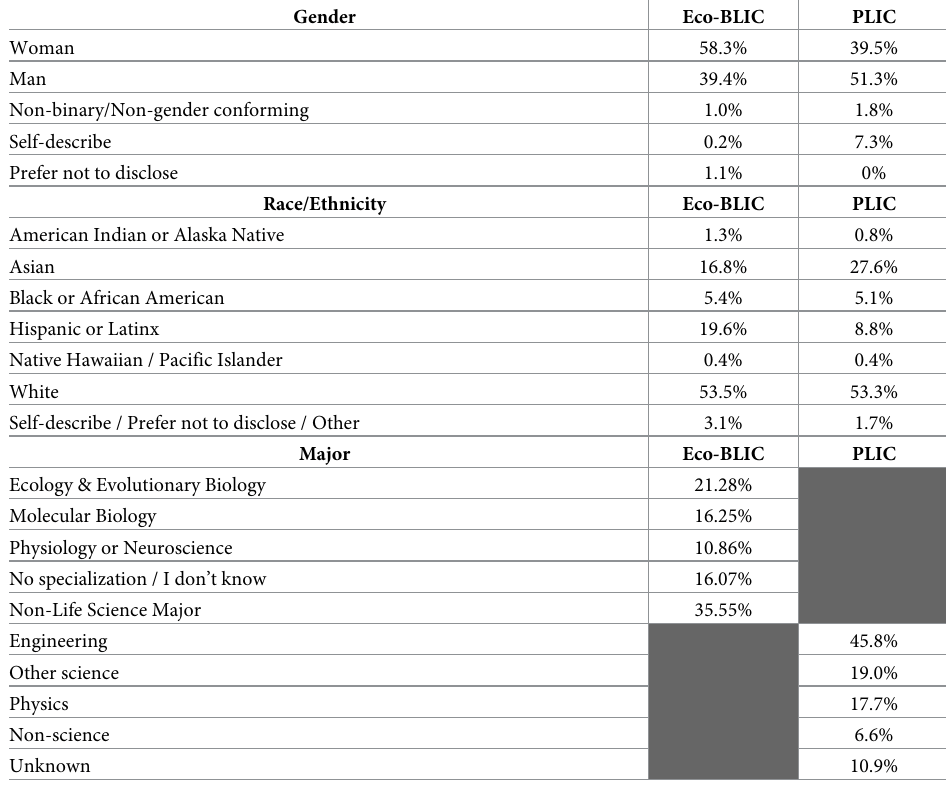
Table 1. Submitted responses broken down by demographic